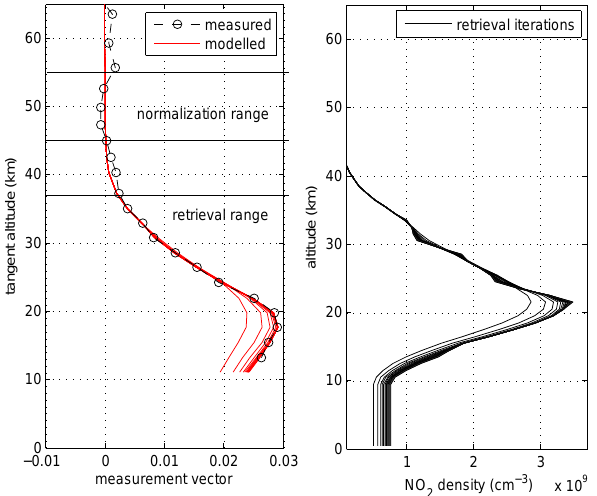
Fig. 3. The convergence of the measurement vector and the re- trieved NO 2 profile. The left panel shows the measured vector and its modelled value for the last 10 of 15 iterations of the retrieval. Also indicated in this panel are the range over which the vector is normalized and the range over which the NO 2 is retrieved.